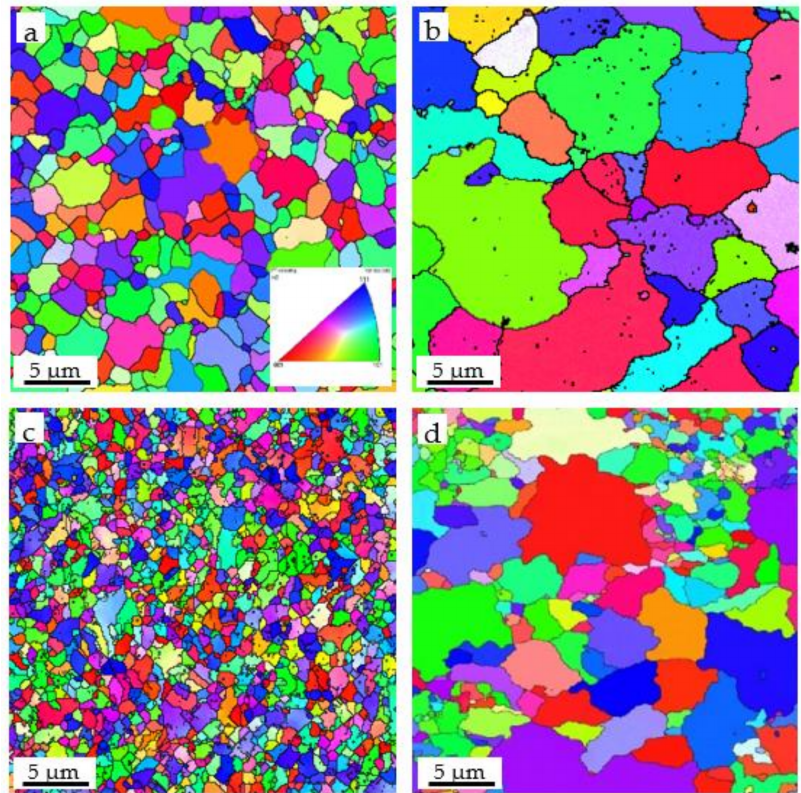
Figure 5. Electron backscattered diffraction (EBSD) analyses of the Fe-Cr-Al specimen before ( a ) and after ( b ) high-temperature oxidation, and Fe-Cr-Al ODS specimen before ( c ) and after ( d ) high- temperature oxidation.